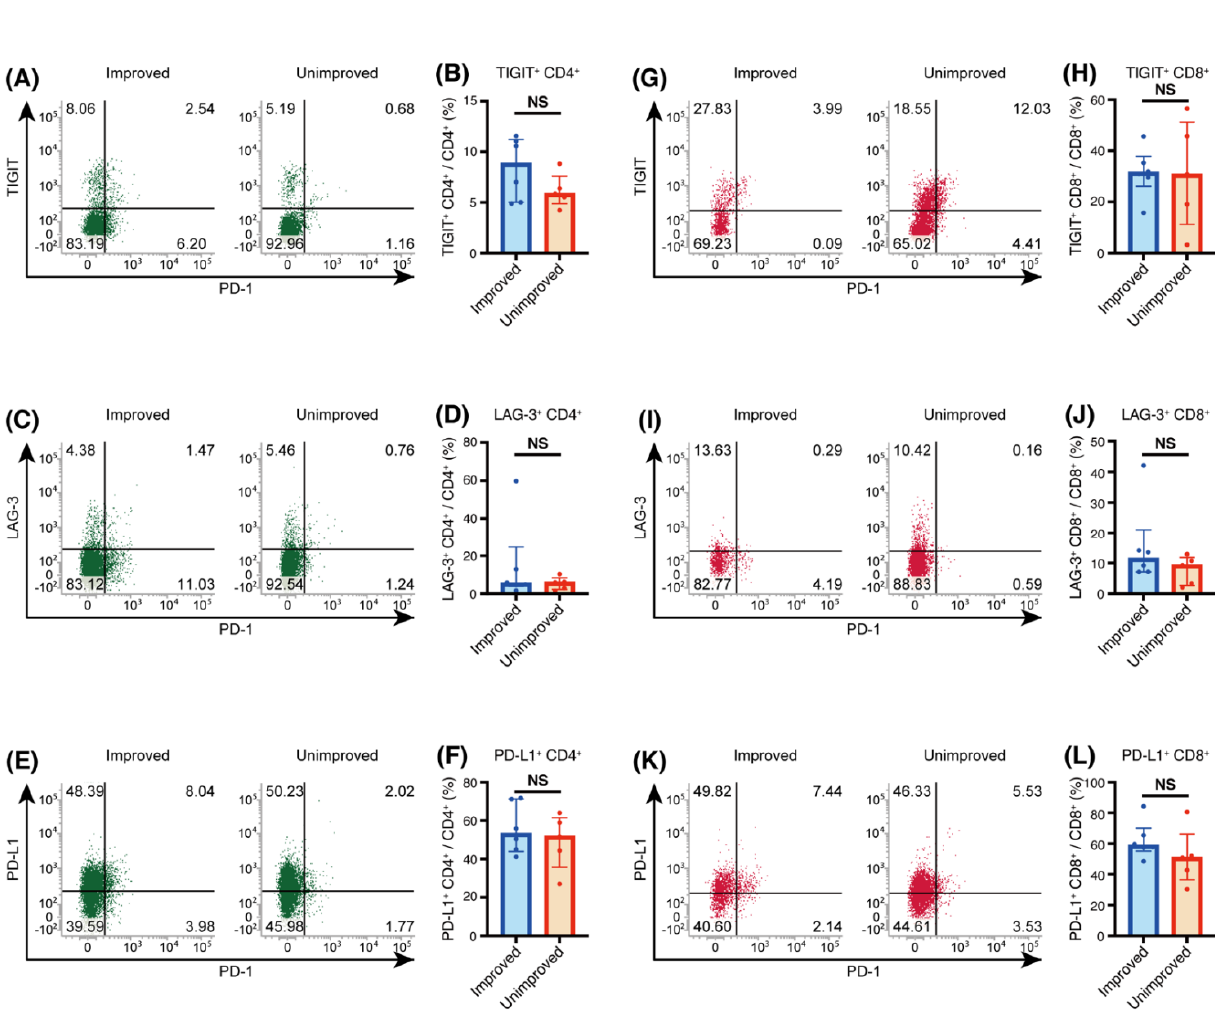
Figure 3. T cell immunoglobulin and ITIM domain (TIGIT), lymphocyte activation gene 3 (LAG-3), and programmed cell death 1 ligand 1 (PD-L1) expression on CD4 + and CD8 + T cells in bronchoalveolar lavage fluid (BALF). ( A , G ) Representative flow cytometric analysis of TIGIT expression on CD4 + T cells ( A ) and CD8 + T cells ( G ) in BALF. ( C , I ) Representative flow cytometric analysis of LAG-3 expression on CD4 + T cells ( C ) and CD8 + T cells ( I ) in BALF. ( E , K ) Representative flow cytometric analysis of PD-L1 expression on CD4 + T cells ( E ) and CD8 + T cells ( K ) in BALF. ( B , H ) Percentages of TIGIT + cells among CD4 + T cells ( B ) and CD8 + T cells ( H ). ( D , J ) Percentages of LAG-3 + cells among CD4 + T cells ( D ) and CD8 + T cells ( J ). ( F , L ) Percentages of PD-L1 + cells among CD4 + T cells ( F ) and CD8 + T cells ( L ). ( B , D , F , H , J , L ) Individual patient data as well as medians and interquartile ranges are shown. NS: not significant.